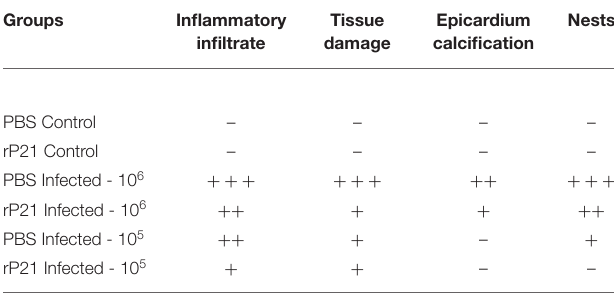
TABLE 1 | Qualitative analyses of alterations in heart tissue.